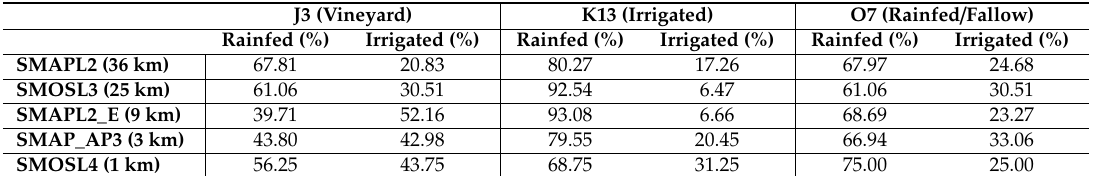
Table 4. Percentage of rainfed and irrigated croplands (the two most common land covers over the REMEDHUS network) within the SMOS and SMAP pixels (36 km, 25 km, 9 km, 3 km and 1 km) enclosing the in situ stations J3 (vineyard), K13 (irrigated) and O7 (rainfed / fallow). J3